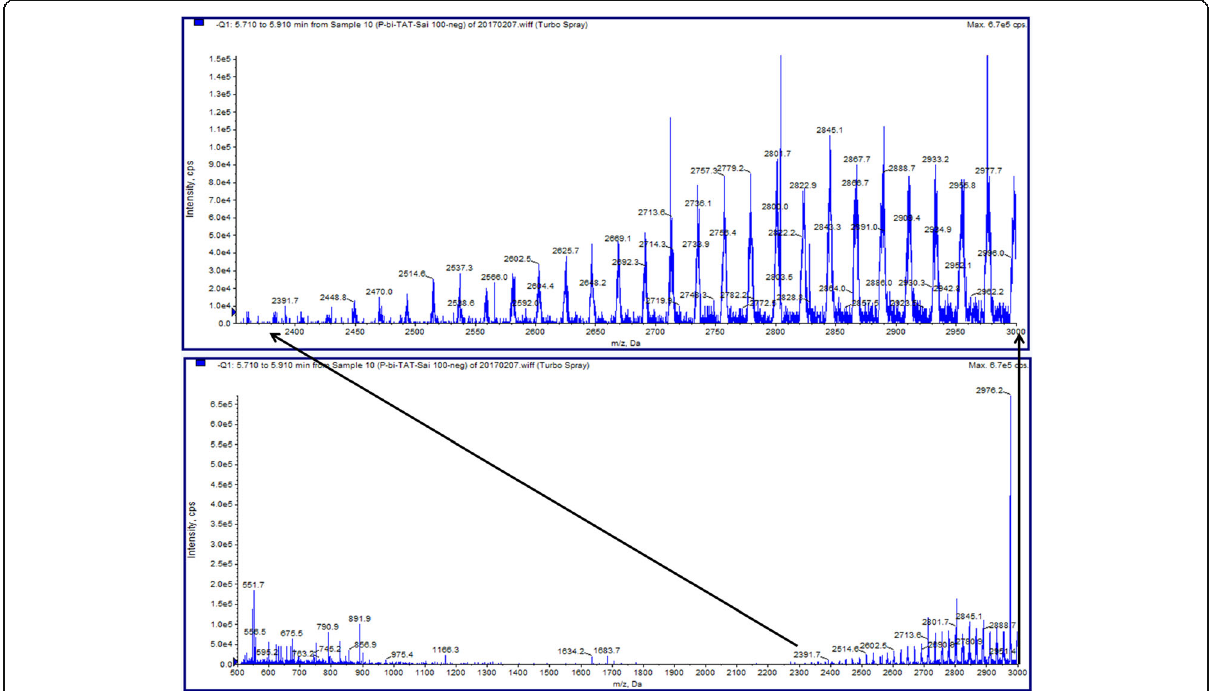
Fig. 2 Mass spectrum of P-bi-TAT in negative ESI scan mode